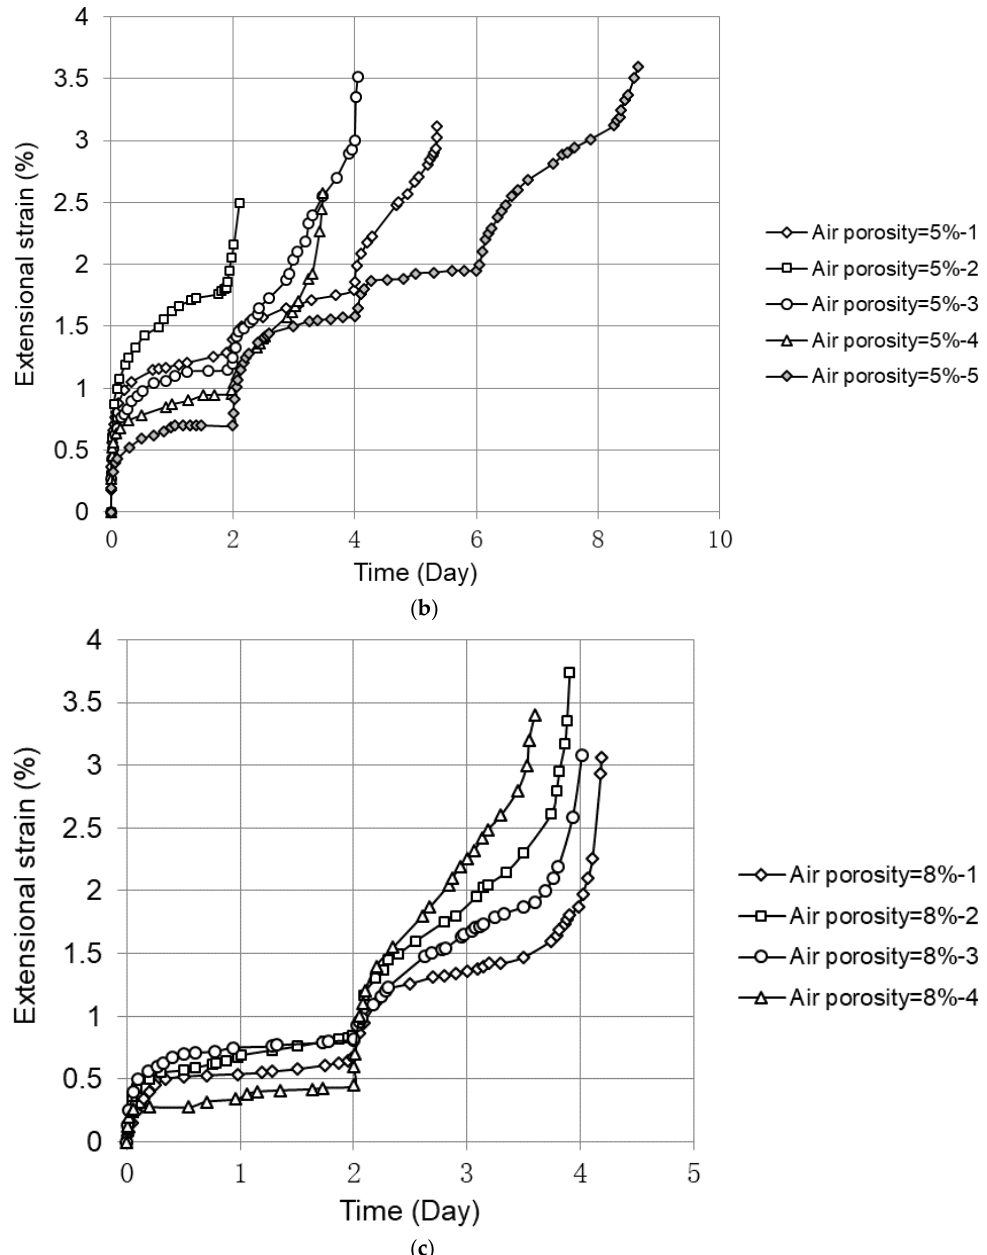
Figure 8. Extensional strain vs. time for the specimens with different air porosities in the middle part of the specimens at 5 °C and at 20 °C by applying various step creep loading, step loading every 2